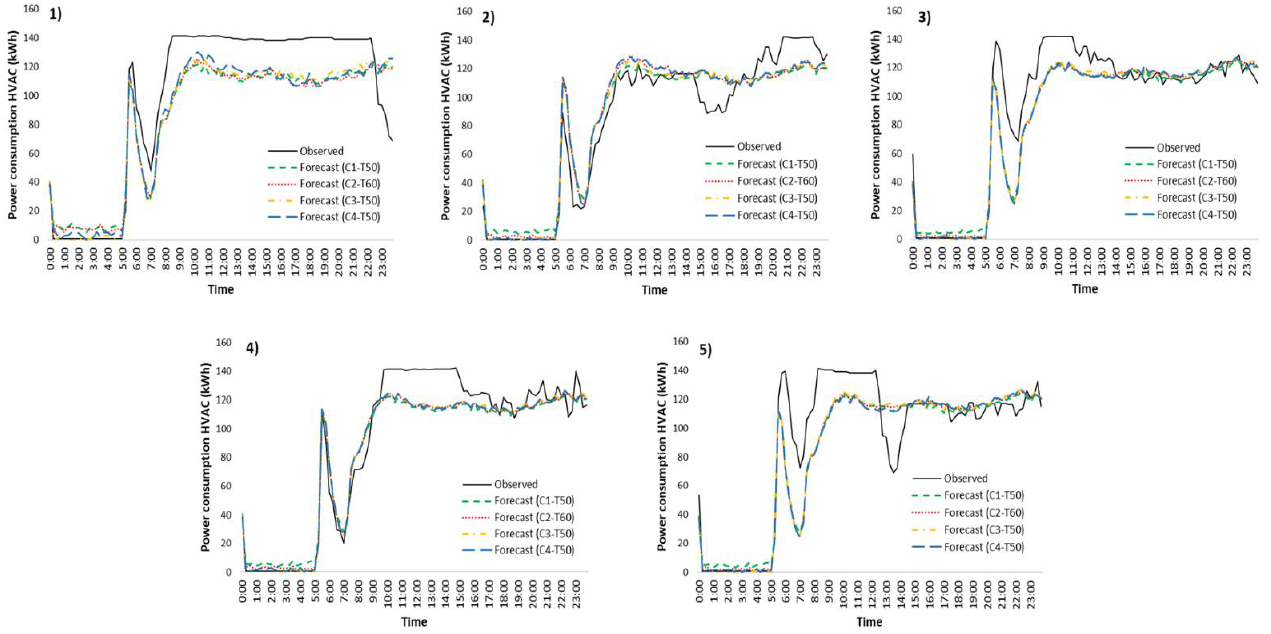
Figure 8. Comparison of the observed values with those predicted by the configurations obtained (C1-T50, C2-T60, C3-T50, C4-T50) for the daily energy consumption of the heat pump.